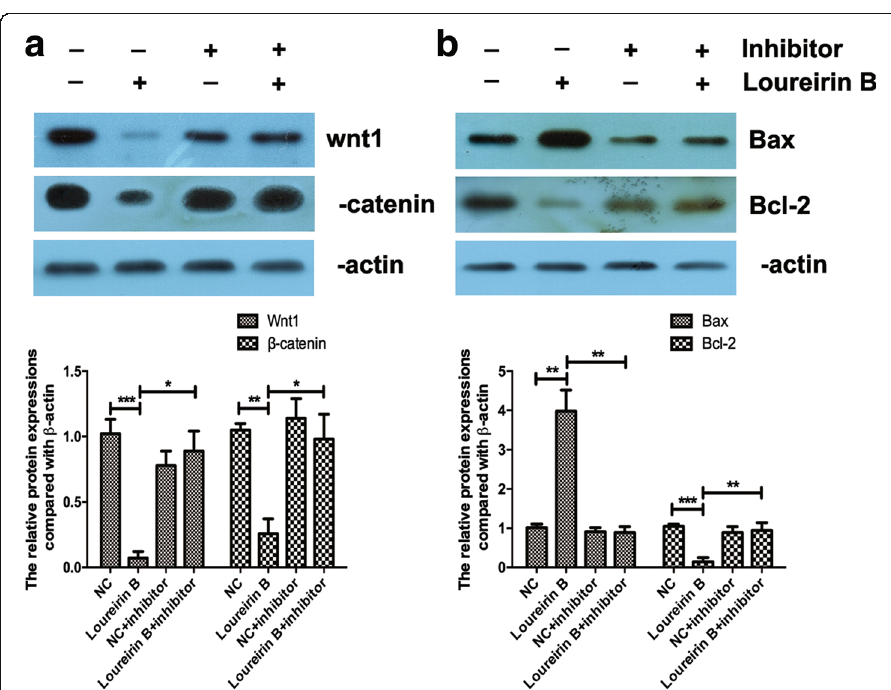
Fig. 5 Loureirin B regulated the Wnt/ β -catenin signaling pathway and the expressions of Bax and Bcl-2 via upregulation of miR-148-3p. a Knockdown of miR-148-3p increased the loureirin B-decreased Wnt1 and β - catenin, as detected via western blot. b Knockdown of miR-148-3p downregulated the loureirin B-increased Bax and upregulated the loureirin B-decreased Bcl-2 expression. Data are the means ± SEM from four independent experiments. * p < 0.05; ** p < 0.01; *** p <